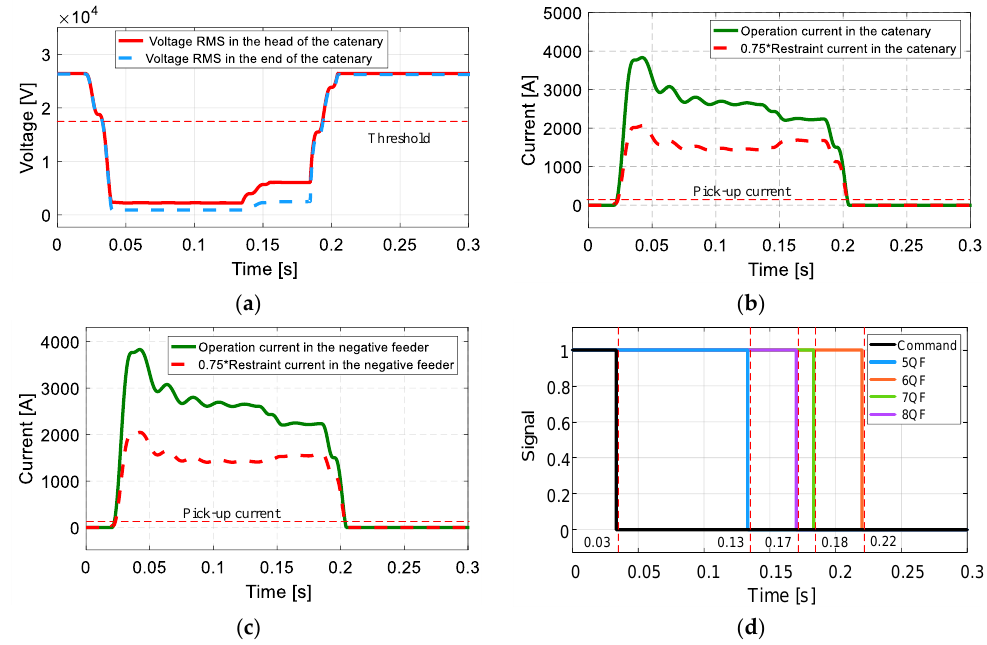
Figure 14. Catenary voltage RMS, operation and restraint current, and signals in the C-NF fault at the AT subsection 2: ( a ) Catenary voltage RMS in the TS and ATS; ( b ) operation current and restraint current in the catenary; ( c ) operation current and restraint current in the negative feeder; and ( d ) signals of the command and the circuit